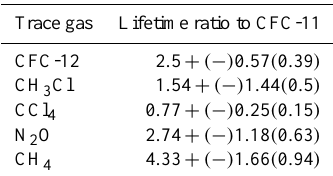
Table 5. The ratio of τ χ /τ CFC-11 for CFC-12, CCl 4 , CH 4 , CH 3 Cl and N 2